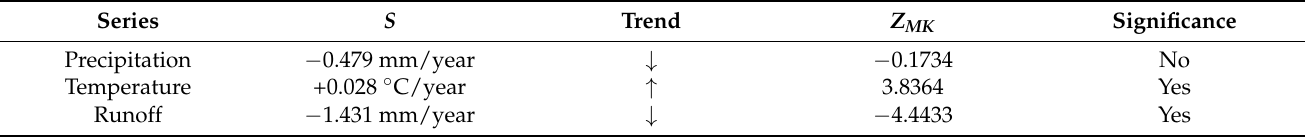
Figure 3. The interannual ( a , c ) and seasonal ( b ) variations of precipitation (mm), temperature (°C), and runoff (mm) series during 1973–2014 in the upper Tang River catchment. Table 1. Trend test results of annual precipitation, temperature, and runoff during 1973–2014.